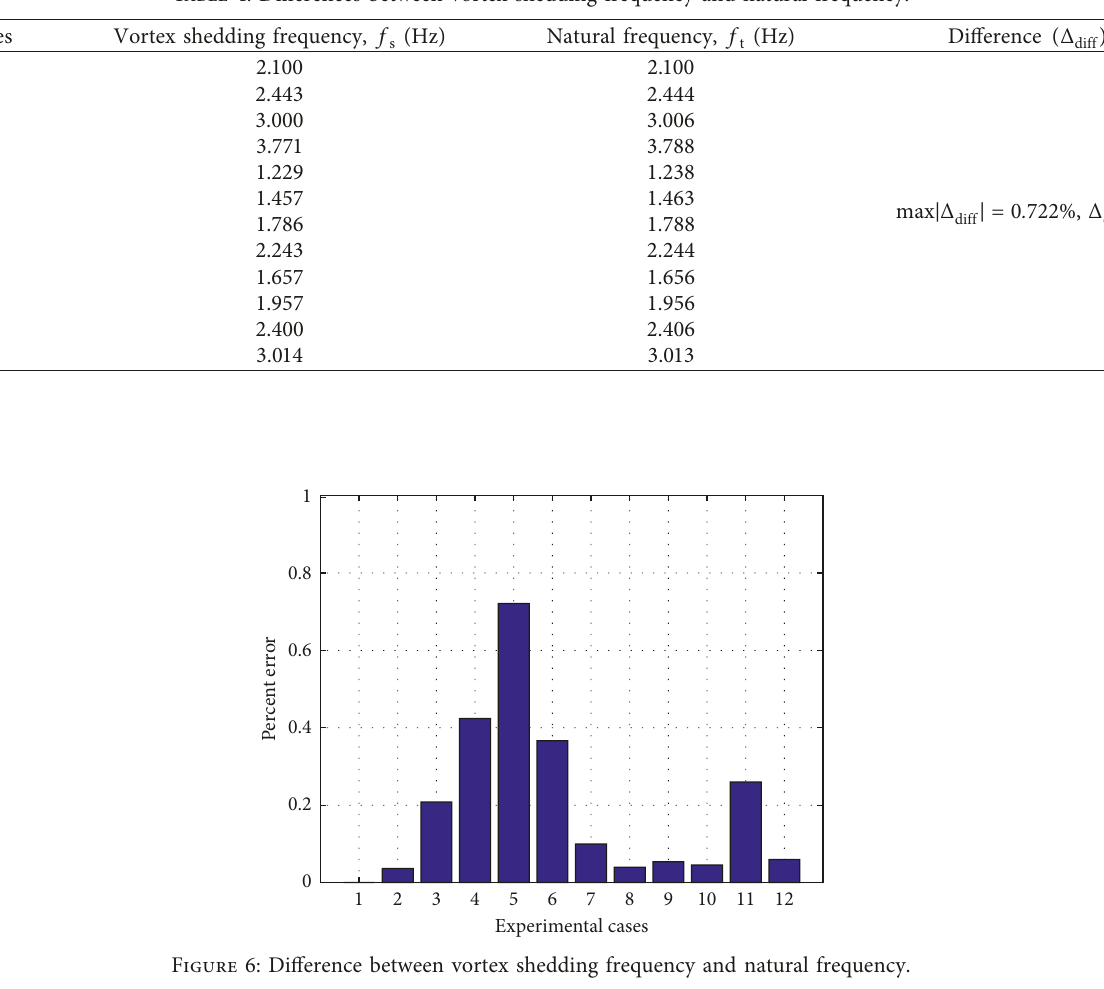
Table 4: Differences between vortex shedding frequency and natural frequency.